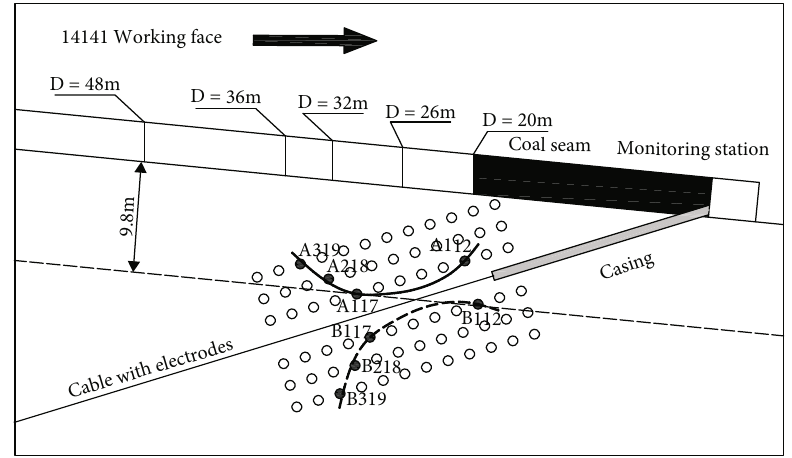
Figure 19: Spatial distribution and maximum failure depth of geological